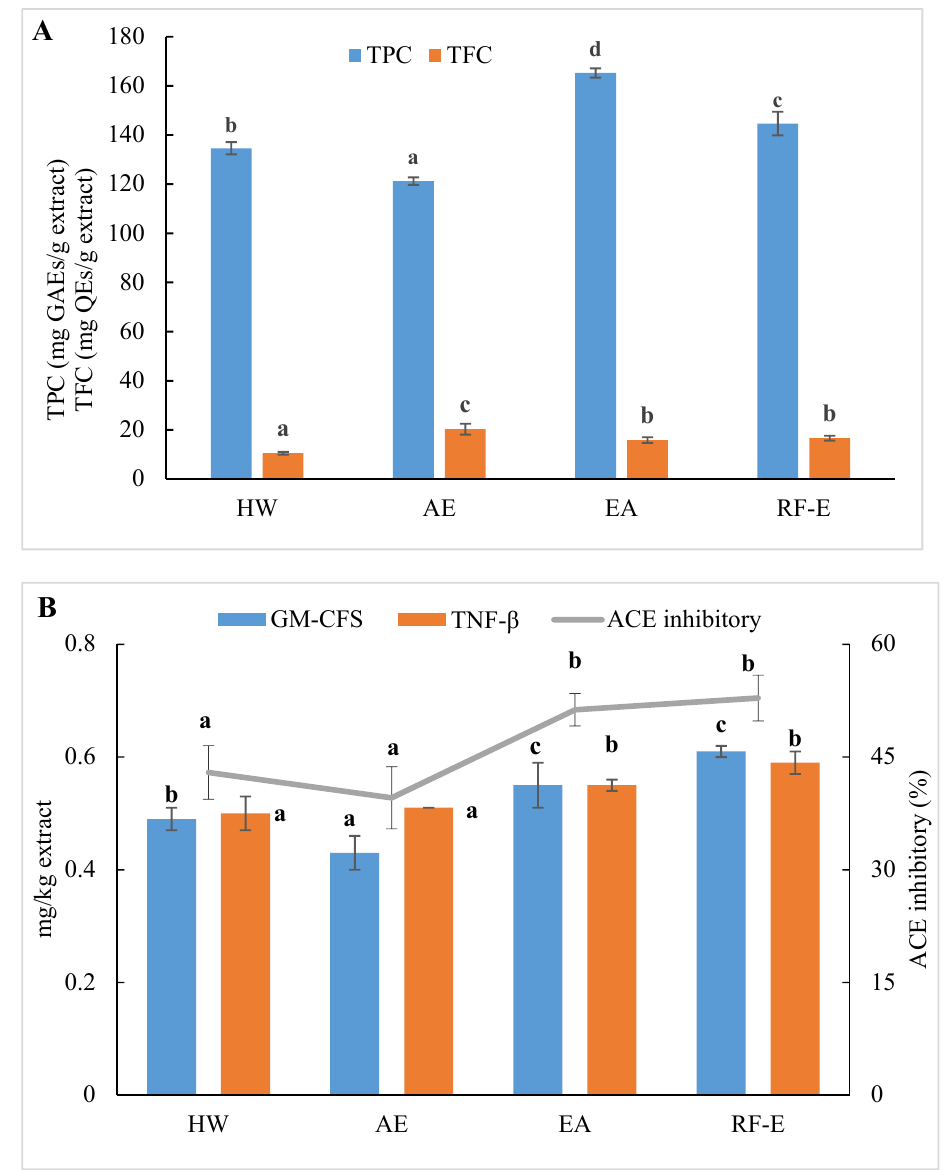
Figure 1. Effects of RF-E and conventional extractions of ( A ) phenolic compound levels and ( B ) biological activities of A. trifoliata flower extracts. Mean ± standard deviation ( n = 3). Different lowercase letters in the same color column show significant differences at the p < 0.05 determined by Duncan’ s multiple range tests. HW, hot water extract; AE, acidified ethanol extract; EA, enzymatic assisted extract; RF-E, radio frequency dielectric heating-assisted enzymatic extract; TPC, total phenolic; TFC, total flavonoids; GAE, gallic acid equivalents; QE, quercetin equivalents; ACE, Angiotensin-I converting enzyme; GM-CSF, granulocyte-macrophage colony-stimulating factor; TNF- β , tumor necrosis factor β .